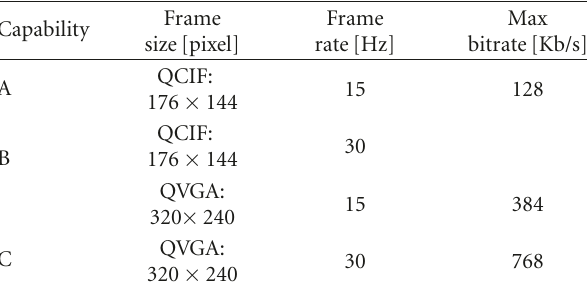
Table 4: Capability classes for DVB-H